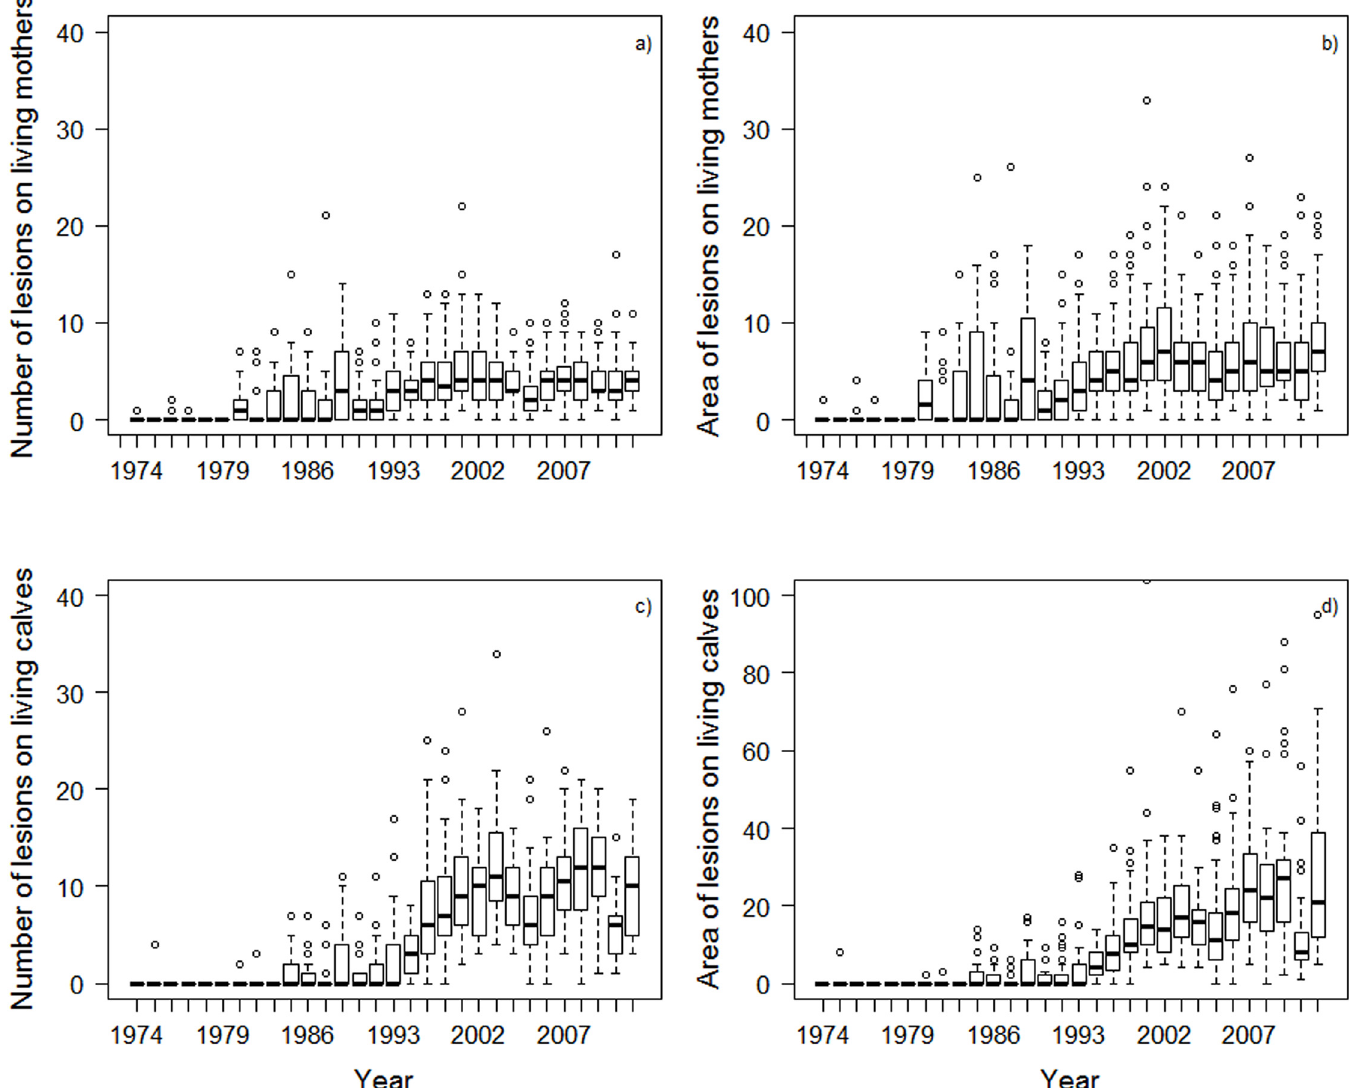
Fig 5. Number and area of lesions on living mothers (a, b) and calves (c, d) in 1974 – 2011. Median values (thick black line), minimum and maximum (whiskers), first and third quartiles (thin black lines), and outliers (open circles) are shown in the figure. Note the different scale for the y axis in the area of lesions on calves (d). To avoid excessively expanding the y-axis in Fig 5d, two extreme values (y = 104 and y = 147 XS lesions) were